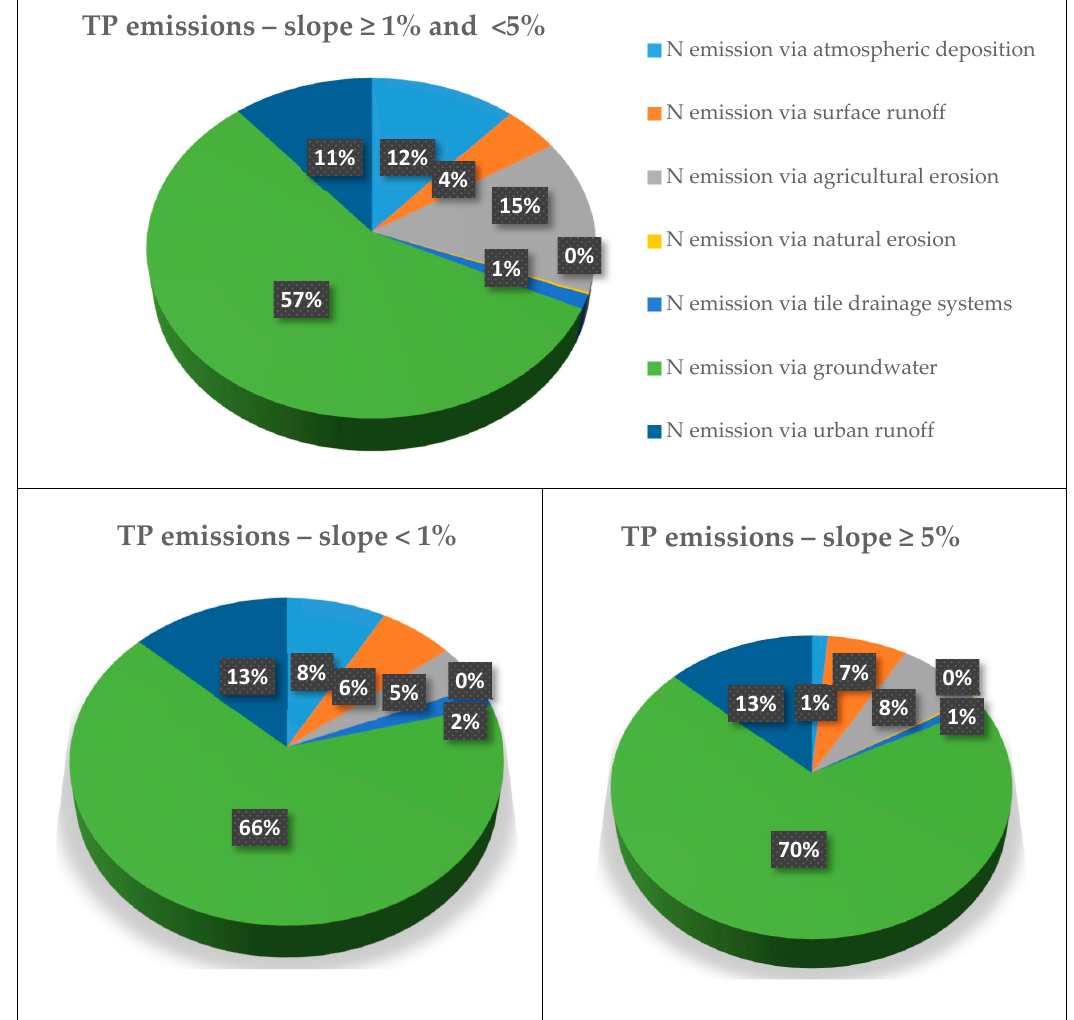
Figure 12. Division of total diffuse-source TN emission per pathway and slope class.